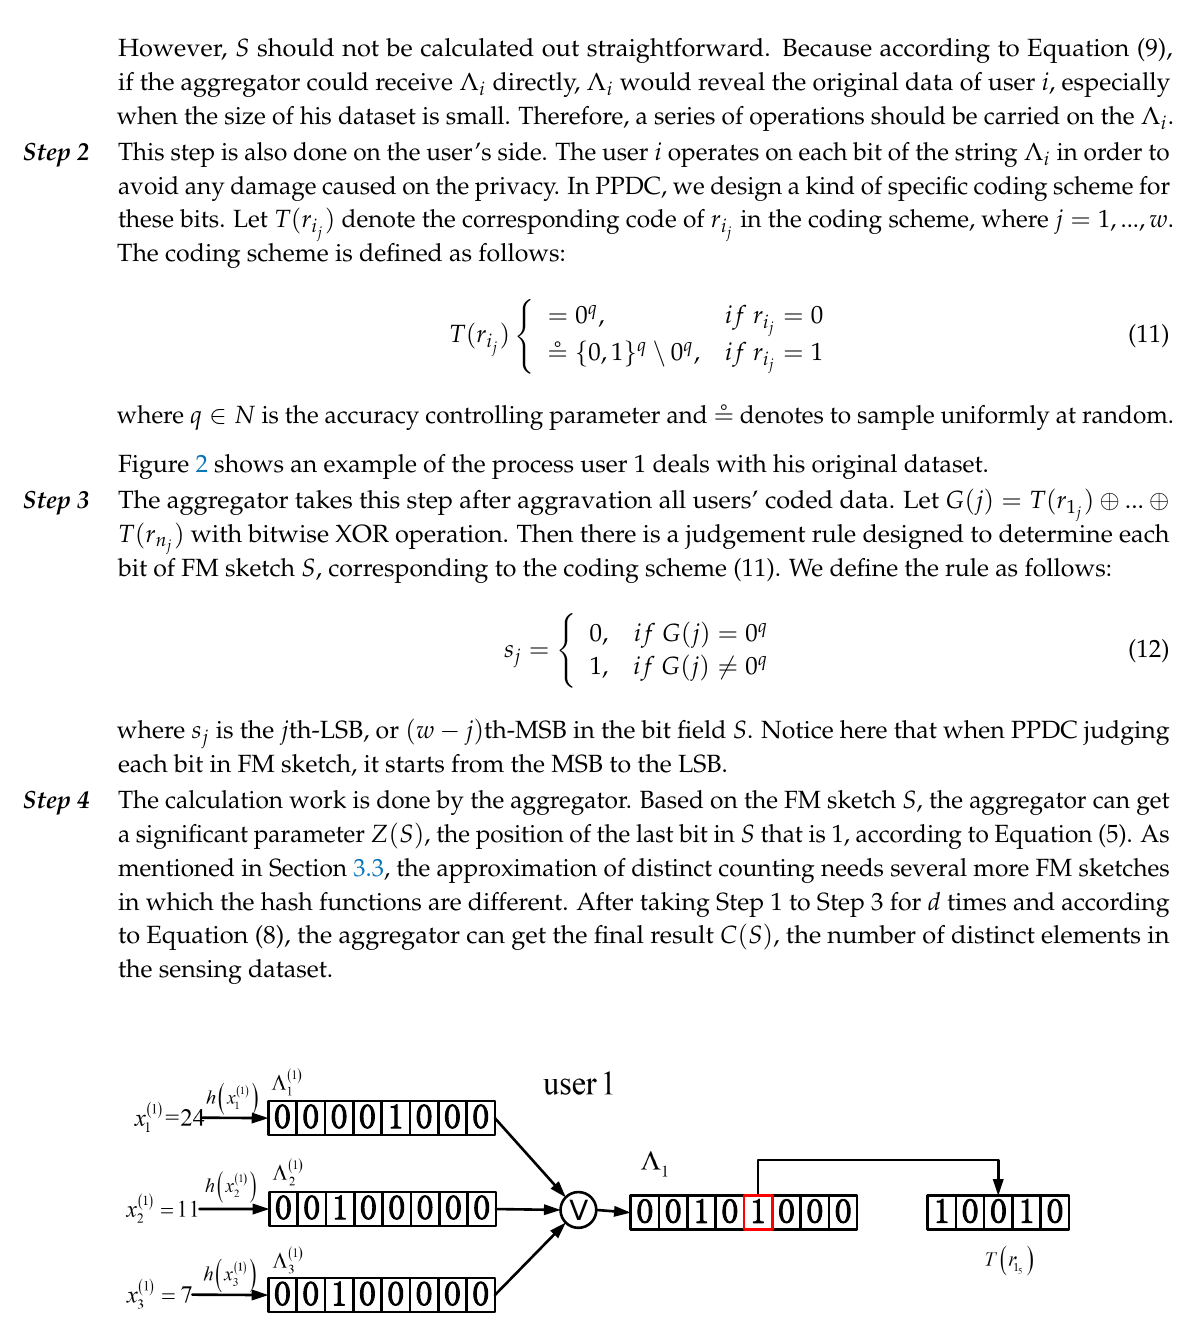
Figure 2. An example of the process that user 1 deals with his original dataset. Here, for example, the elements in the dataset are all integers. User 1 hashes elements of his dataset into 8-bit strings and do the bitwise OR operation to get a string as the representation of his dataset. Then each bit of this string is coded to a 5-bit